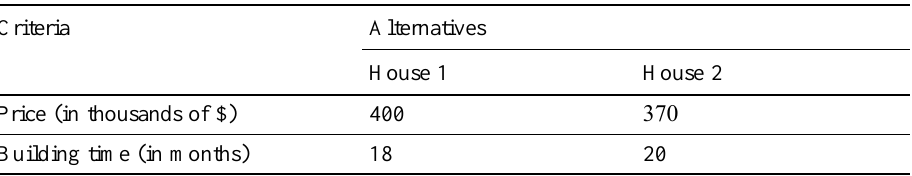
Table 1. Alternatives under consideration